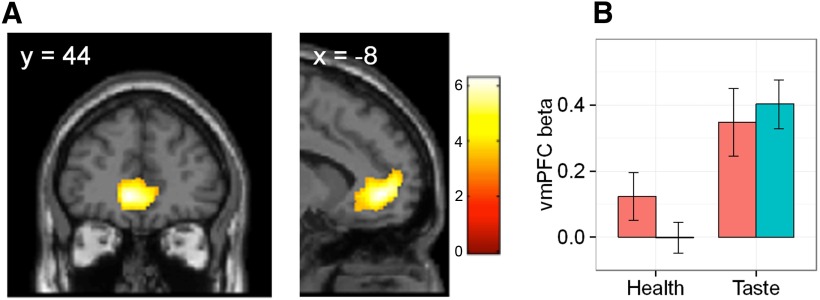
Neural measures of the goal value of food. A, The neural representation of goal value in the vmPFC. The results of the fMRI analysis were rendered onto a standard SPM8 T1 template image, with coronal and sagittal sections presented at the coordinates appropriate for displaying the vmPFC cluster (pFWE < 0.05, corrected at the cluster level; p < 0.001 uncorrected threshold). B, Health and taste beta value extracted from the vmPFC activity, in lean and overweight participants. Error bars represent the SEM.